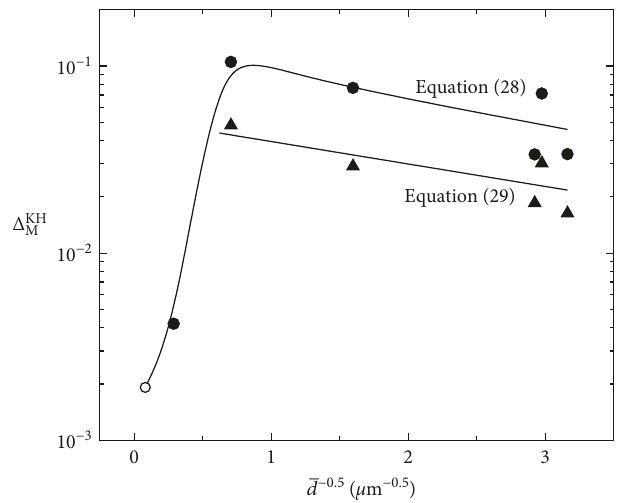
KH on the mean M Δ